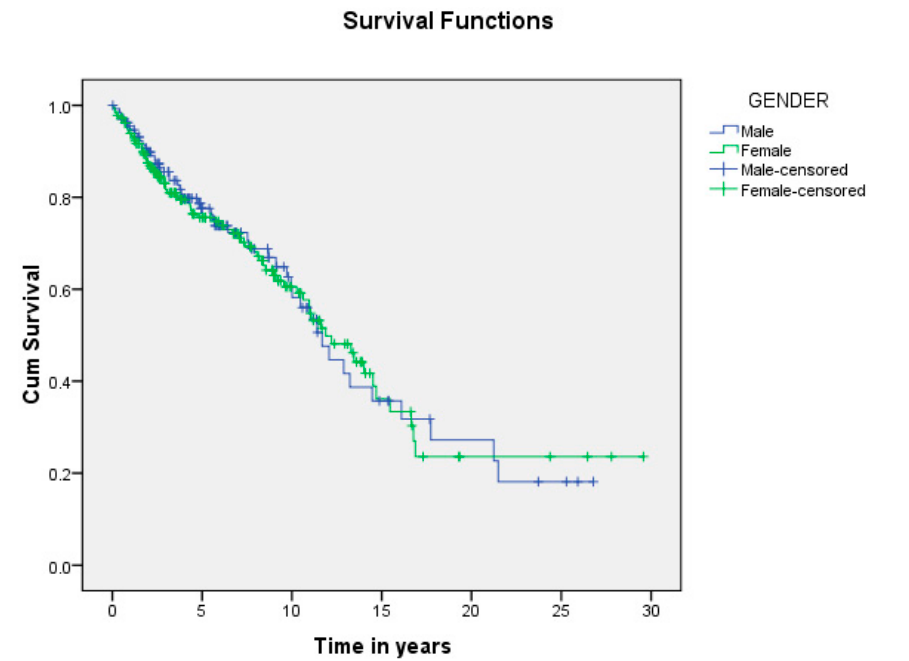
Figure 7. Shows the difference in survival based on patients’ gender. The median survival time in the males was 11.7 ± 1.0 years, and in the females, 11.9 ± 1.1 years, with no significant difference ( p = 0.928).